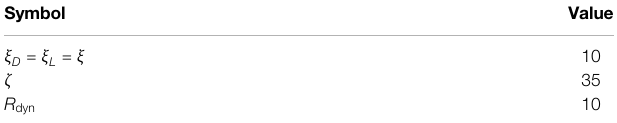
TABLE 4 | Identi fi ed model parameters for the work hardening interaction model TABLE 5 | Model parameters of the dislocation density evolution model. These between slip and twinning systems. parameters are used irrespective of the morphological class ofthe slip system at hand. Due to previous arguments concerning the contribution of the minor α 2 γ phase (slip – twin interaction) phase to the overall plastic deformation, the same parameters were used for the dislocation density evolution in the γ and the α 2